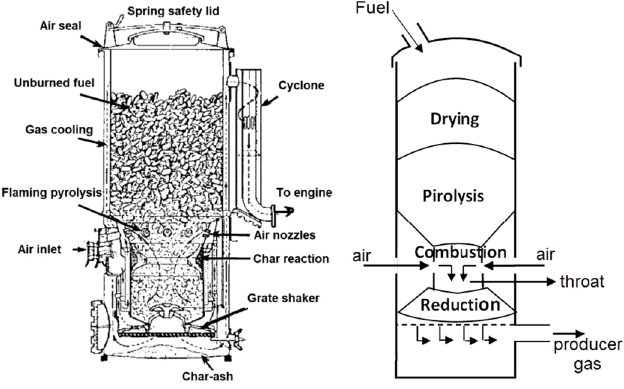
Fig. 1. Downdraft gasi fi ers (cid:2) Imbert